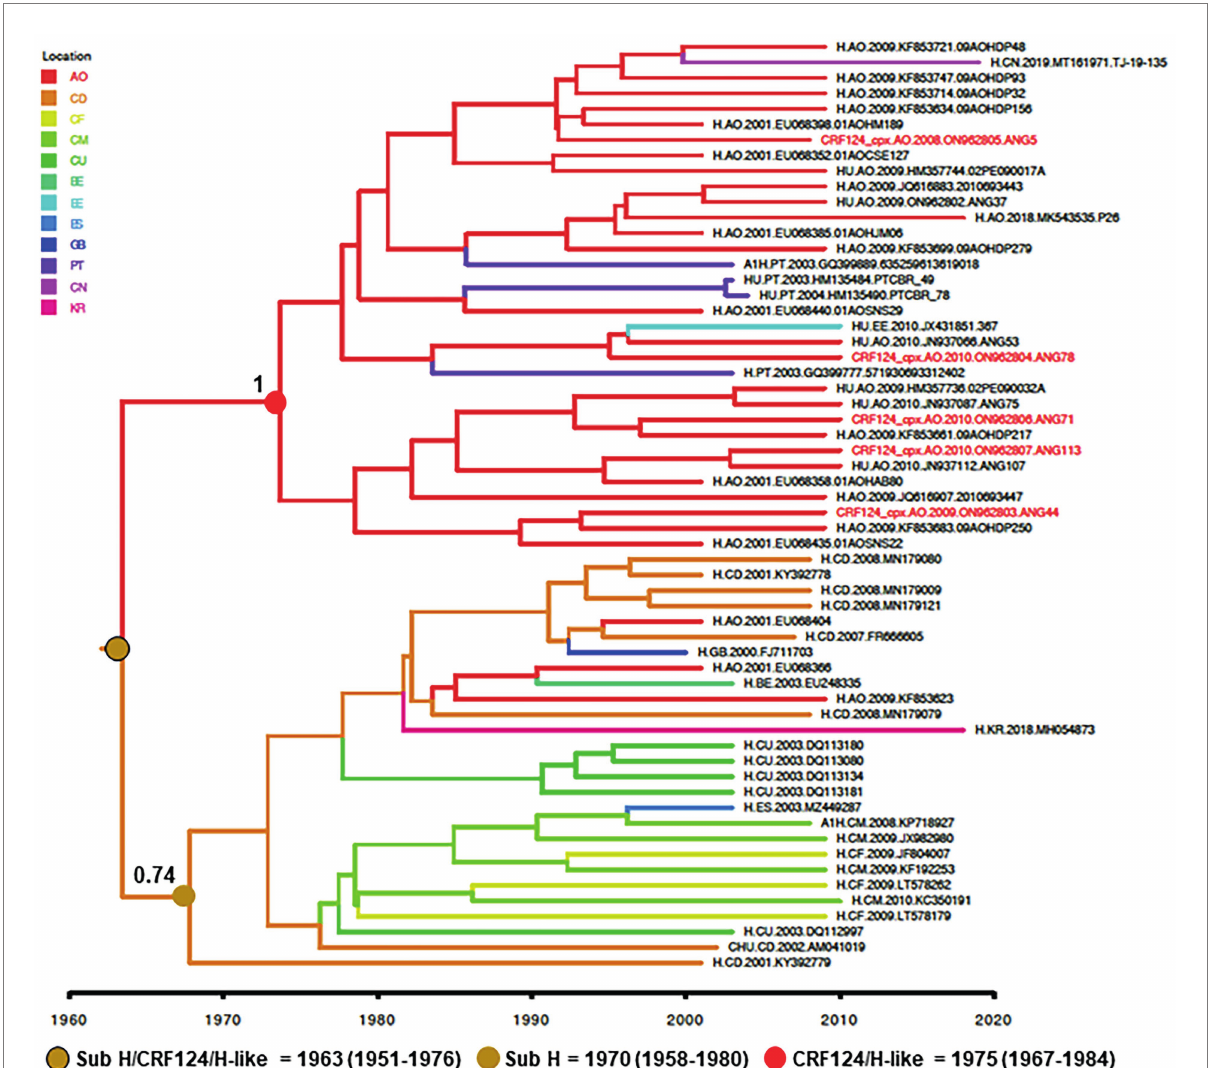
FIGURE 4 Time-scaled Bayesian MCC tree of HIV-1 CRF124_cpx, H and H-like pol sequences (~700 nt). Branches are colored according to the most probable location state of their descendent nodes as indicated in the legend (upper left). Red tips indicate the position of full-length CRF124_cpx sequences. PP support is shown at nodes of subtype H and clade CRF124_cpx/H-like. Branch lengths are drawn to a scale of years. The tree was automatically rooted under the assumption of a relaxed molecular clock. AO, Angola; CD, Democratic Republic of Congo; CF , Central African Republic; CM, Cameroon; CU, Cuba; BE, Belgium; EE, Estonia; ES, Spain; GB, Great Britain; PT, Portugal CN, China; and KR, South